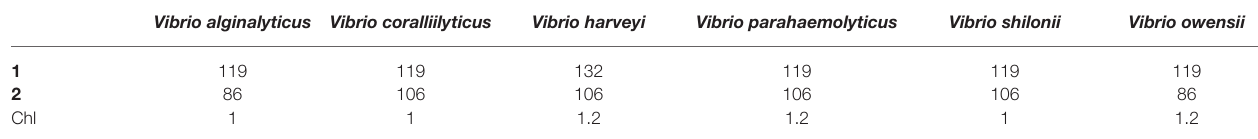
TABLE 2 | Anti- Vibrio activity of compounds 1 and 2 (MIC, μ g/ml).